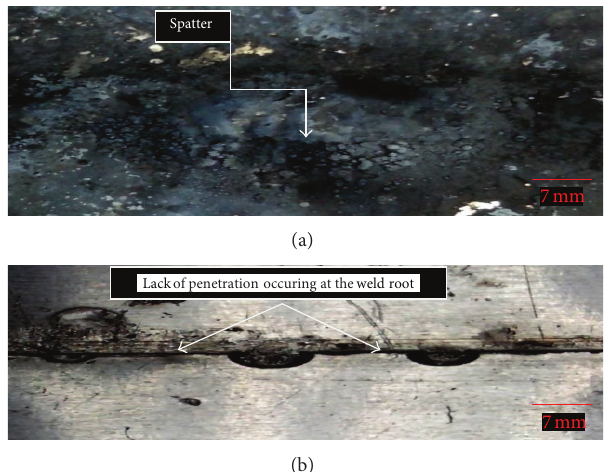
Figure 7: The weld profile of the Al-Al GMAW welded joint at (a) the top side and (b) the bottom side.